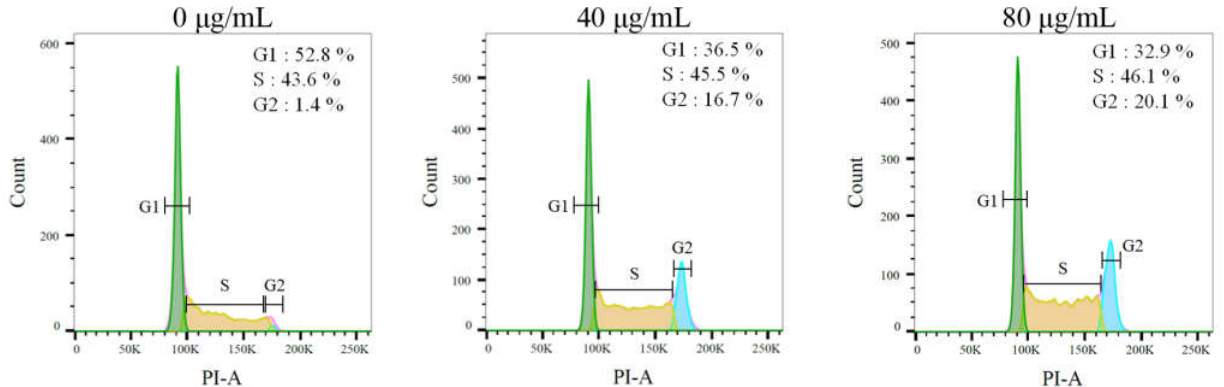
Figure 10. Flow analysis results. B16F10 cells were treated with the stem extract of S. purpurea at indicated concentrations for 24 h and fixed with 70% alcohol overnight. The cell suspension was stained with propidium iodide (PI) for 30 min and subjected to flow cytometry.